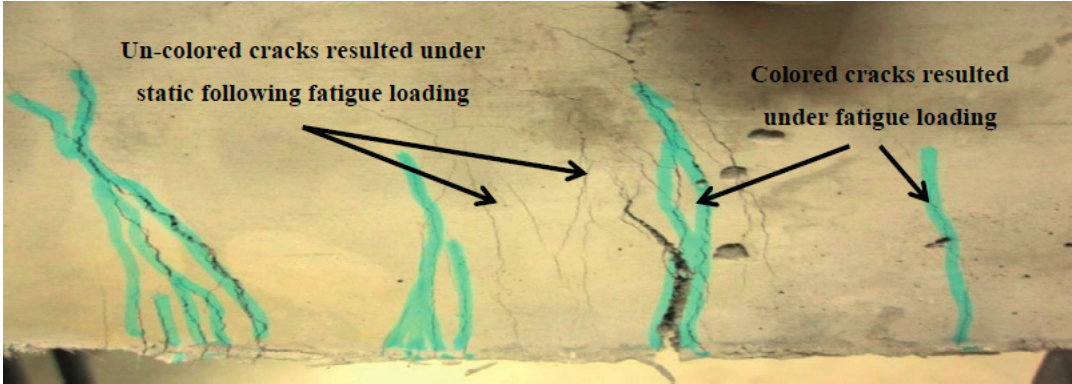
Figure 7. Multiple cracking under flexural fatigue